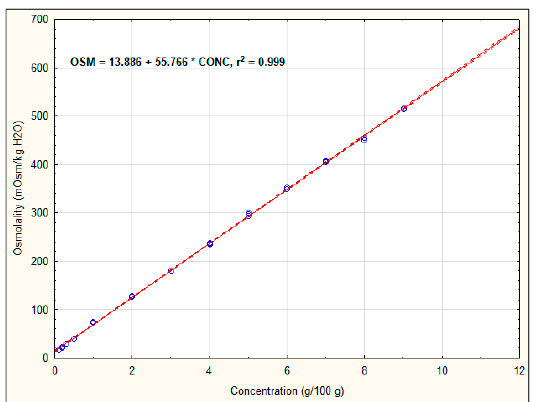
Figure 2. Citric acid osmolalities in aqueous solution.